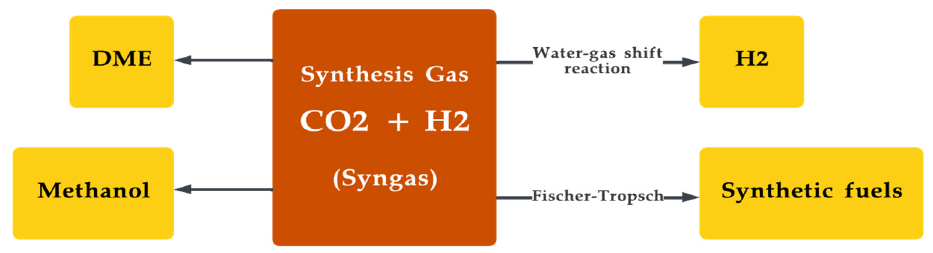
Figure 9. Production of various synthetic fuels from synthesis gas.